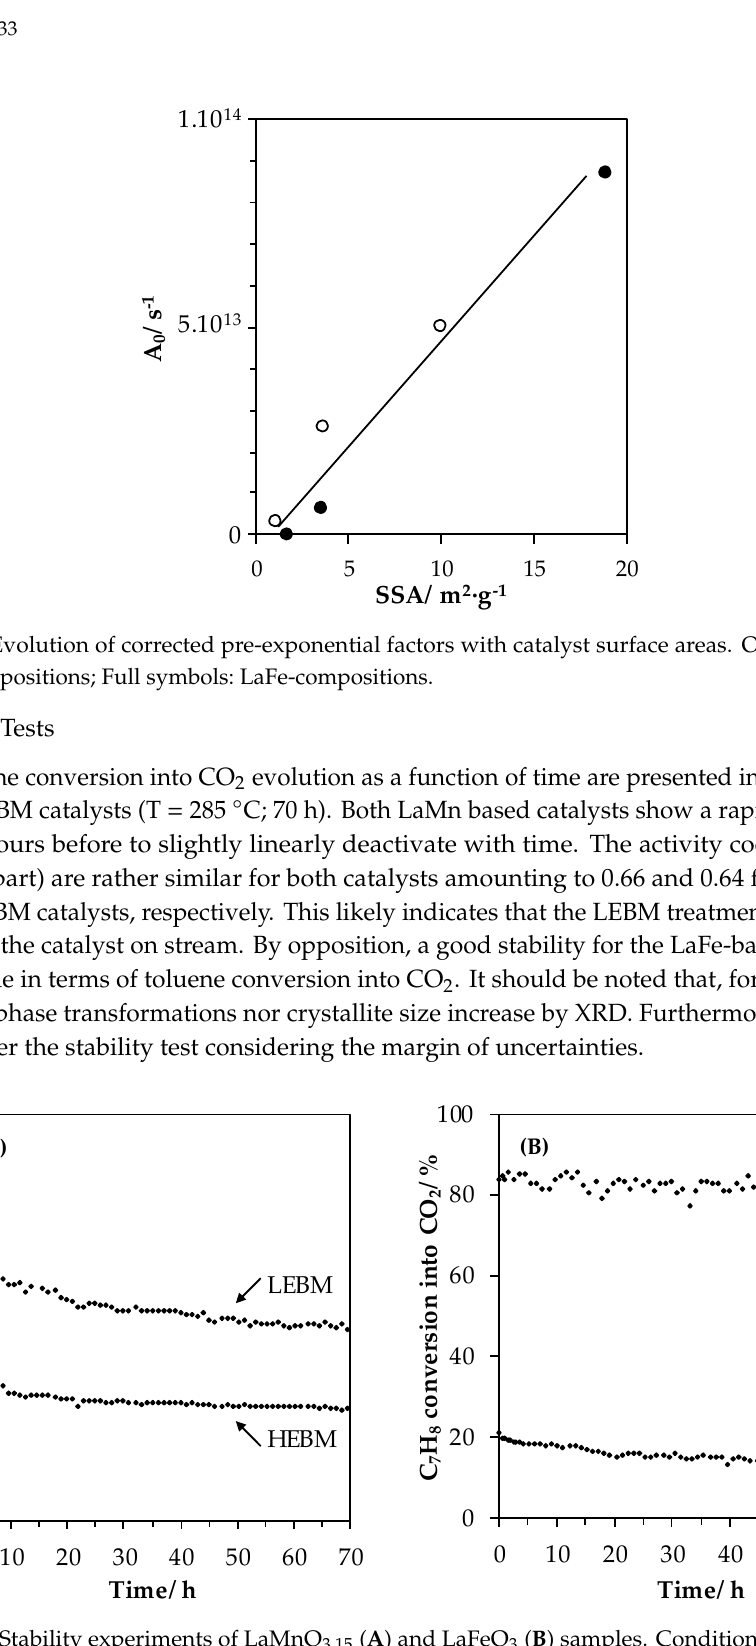
Figure 10. Stability experiments of LaMnO 3.15 ( A ) and LaFeO 3 ( B ) samples. Conditions are: 200 mg of catalyst exposed to 1000 ppmv C 7 H 8 in 100 mL·min −1 of synthetic air (20% O 2 in N 2 ) for 70 h at a